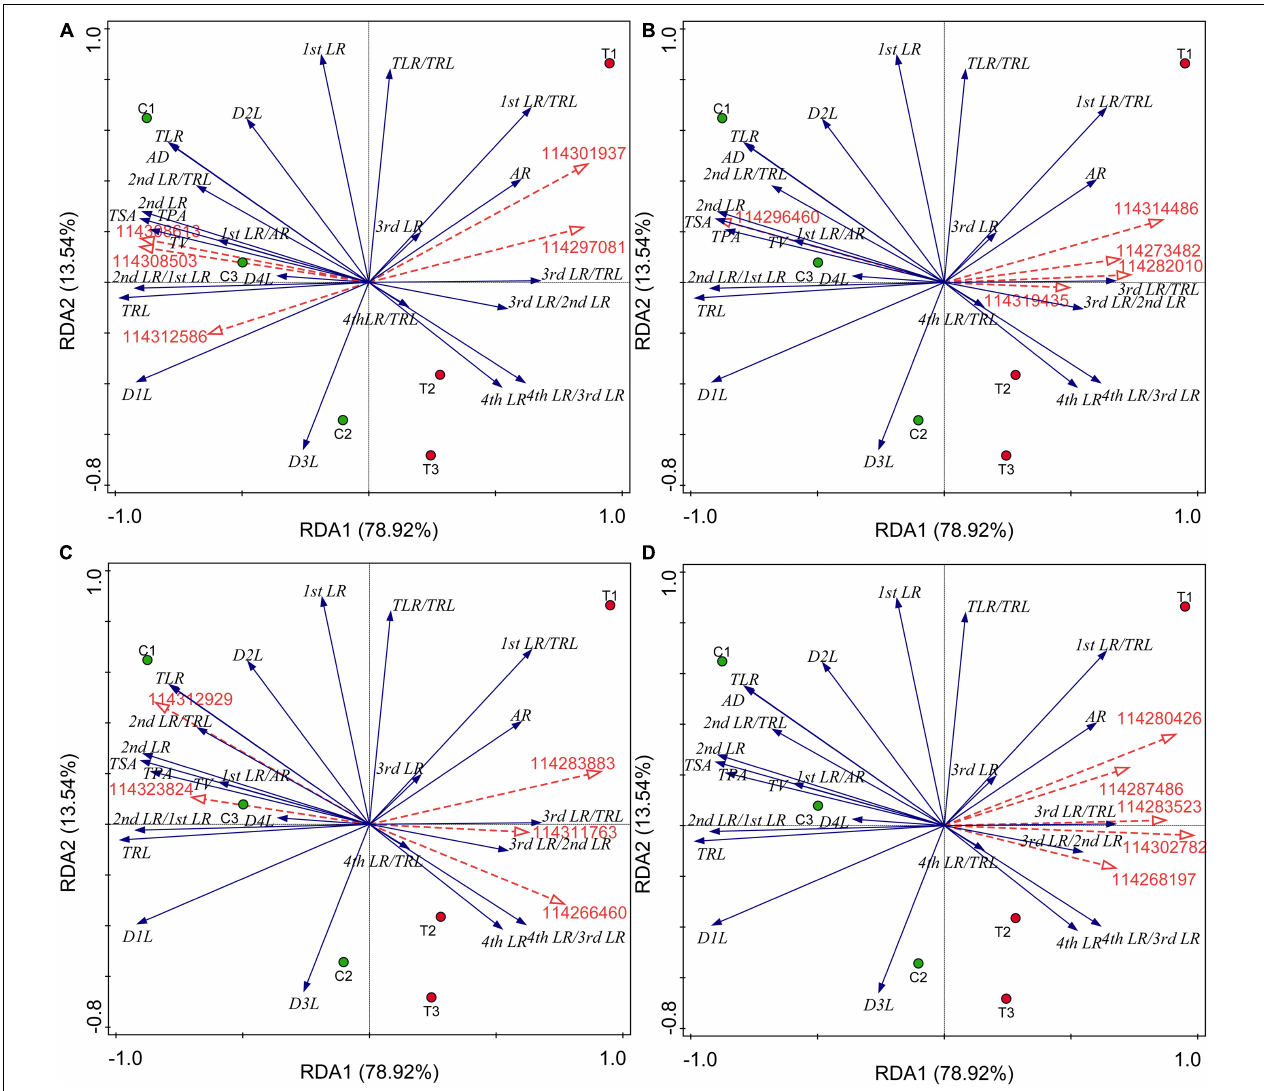
FIGURE 5 | Redundancy analysis (RDA) indicating the correlations between key DEGs related to different categories and root indexes. (A) DEGs related to P metabolism. (B) DEGs related to sugar metabolism; (C) DEGs related to plant hormone; (D) DEGs related to lipid metabolism. Blue and red arrows indicated various root indexes and key DEGs induced by AMF inoculation, respectively. The annotation of DEGs, filled with yellow, was listed in Supplementary Data 2 . AR, adventitious root number; LR, lateral root number; TLR, total lateral root number; TRL, total root length; TPA, total root projected area; TSA, total root surface area; TV, total root volume; AD, average diameter of root; D1L: length of 0.000 mm ≤ AD < 0.500 mm; D2L: length of 0.500 mm ≤ AD < 2.000 mm; D3L: length of 2.000 mm ≤ AD < 3.000 mm; D4L: length of 3.000 mm ≤ AD < 5.000